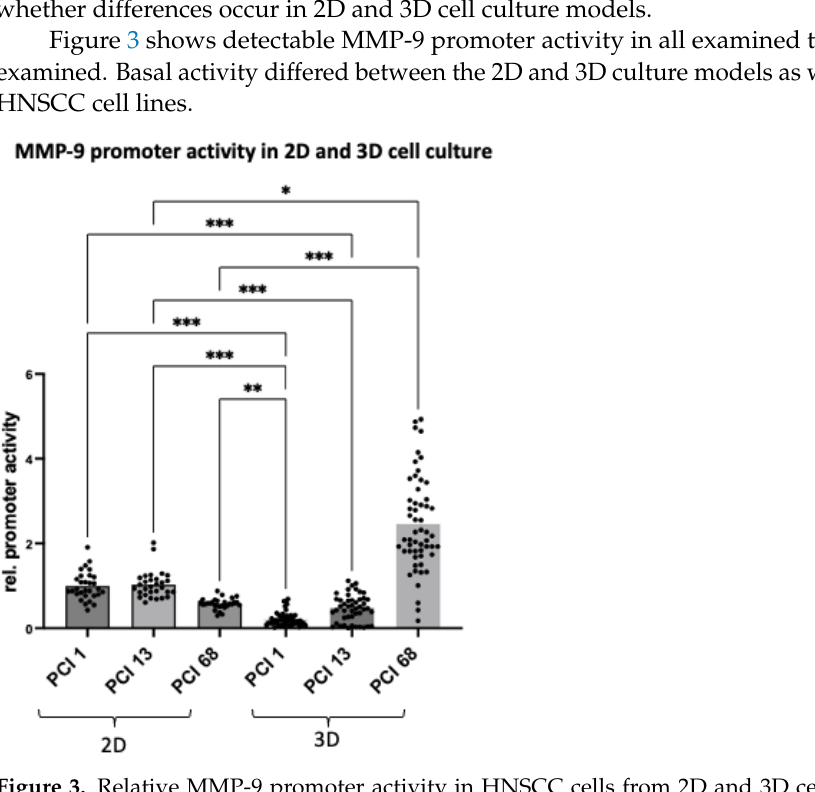
Figure 3. Relative MMP-9 promoter activity in HNSCC cells from 2D and 3D cell cultivation by means of luciferase activity assay. Significant differences can be observed in the MMP-9 promoter activity in the 2D and 3D models. Except for PCI 68, HNSCC cells reveal lower basal MMP-9 promoter activity in 3D spheroid culture. Promoter activity in 2D and 3D cell culture was calculated relative to promoter activity in HNSCC cell line PCI 1 from adherent 2D cell culture. For 3D cell culture, spheroids were cultured for three days. Statistical analysis: ordinary one-way ANOVA, multiple comparisons with Tukey’s correction. * p < 0.05; ** p < 0.01; *** p < 0.001. n ≥ 30.